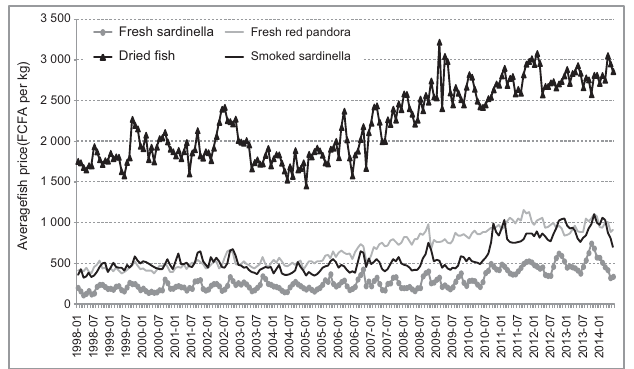
Fig. 3. Long-term linear trends of the consumer price index for fi sh ( IF , in full line) and for all goods and services ( IG , in broken line) from 1998 to 2014 in